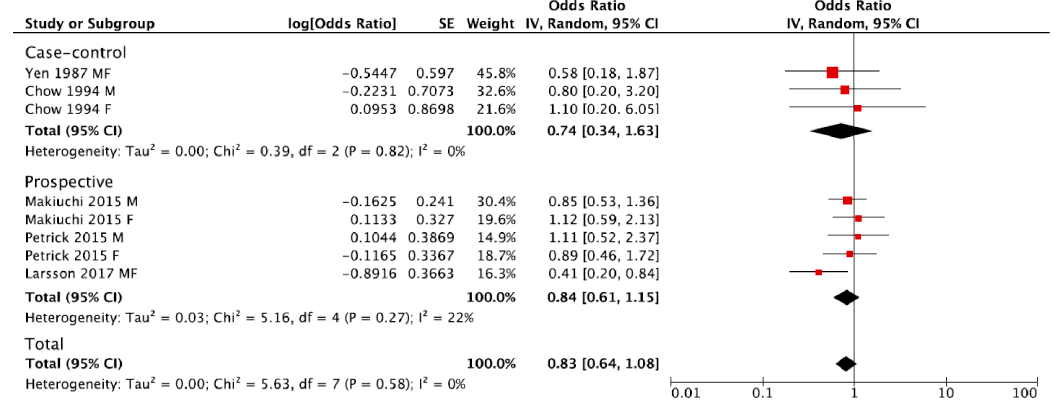
Figure 2. Forest plot of summary relative risks (RRs) of BTC for the highest versus lowest (reference) category of coffee consumption, by study design.